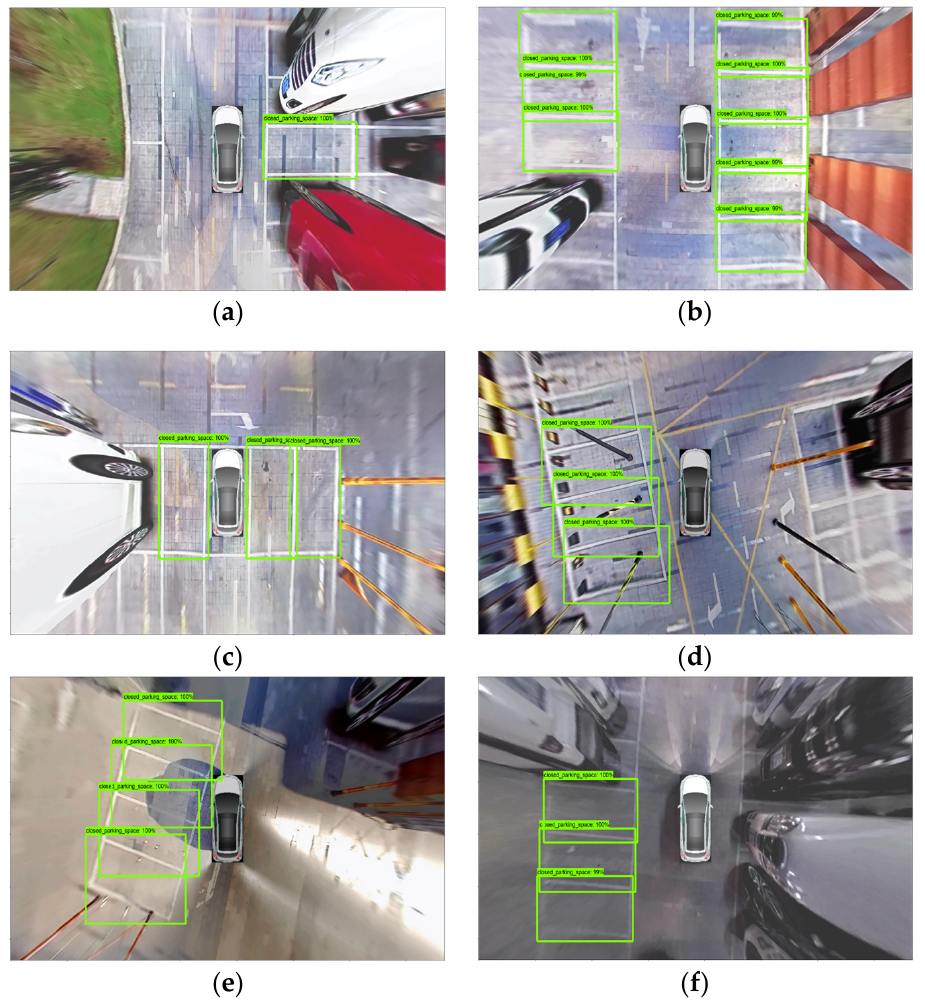
Figure 18. Test results. ( a ) Scene with fewer parking spaces. ( b ) Scene with lots of parking spaces. ( c ) Side parking scene. ( d ) Complex scene with ground marking lines. ( e ) Scene with complex lighting environment and lots of shadows. ( f ) Night scene.